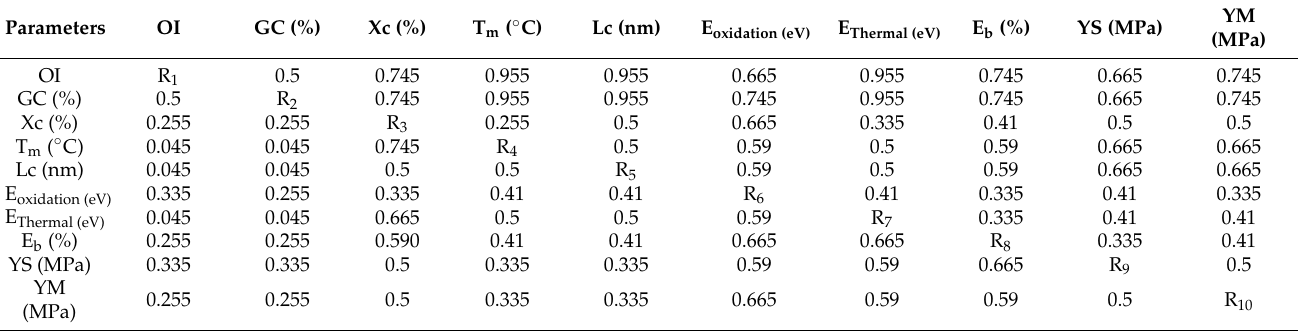
Table 2. Adjacency matrix from the material selection graph (Figure 3) with relative importance among the attributes as off-diagonal elements obtained from 11-point fuzzy logic conversation scale.